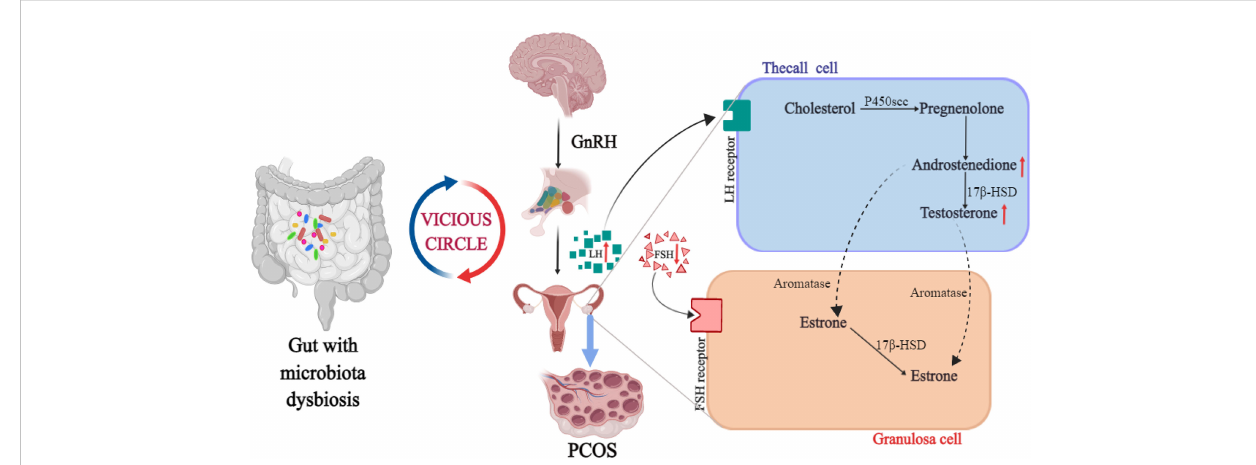
FIGURE 1 The intrinsic relationship between HA, intestinal fl ora and